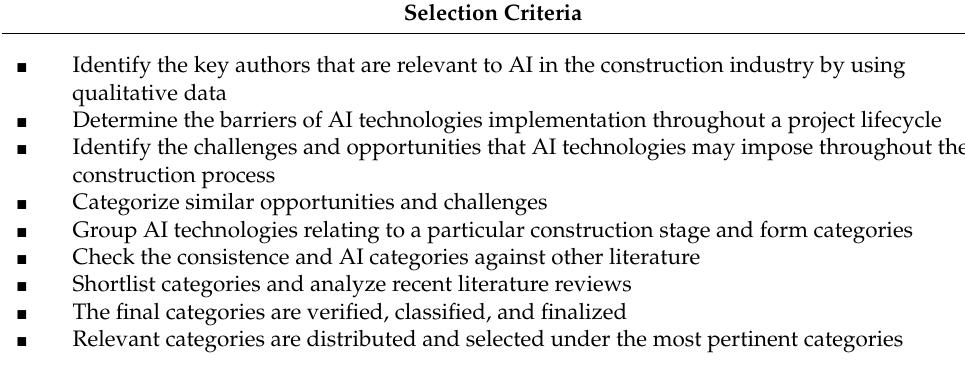
Table 3. Category formulation criteria, derived from [43,44].